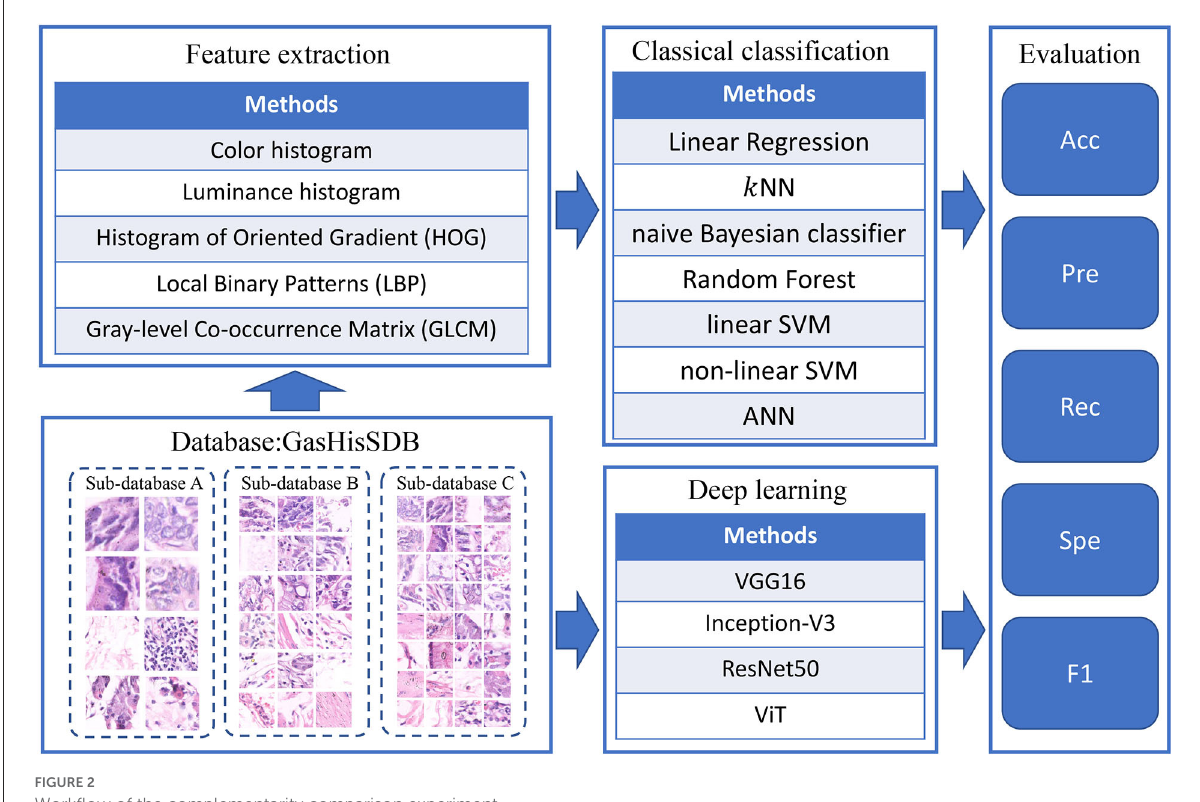
FIGURE2 Workflow of the complementarity comparison experiment.